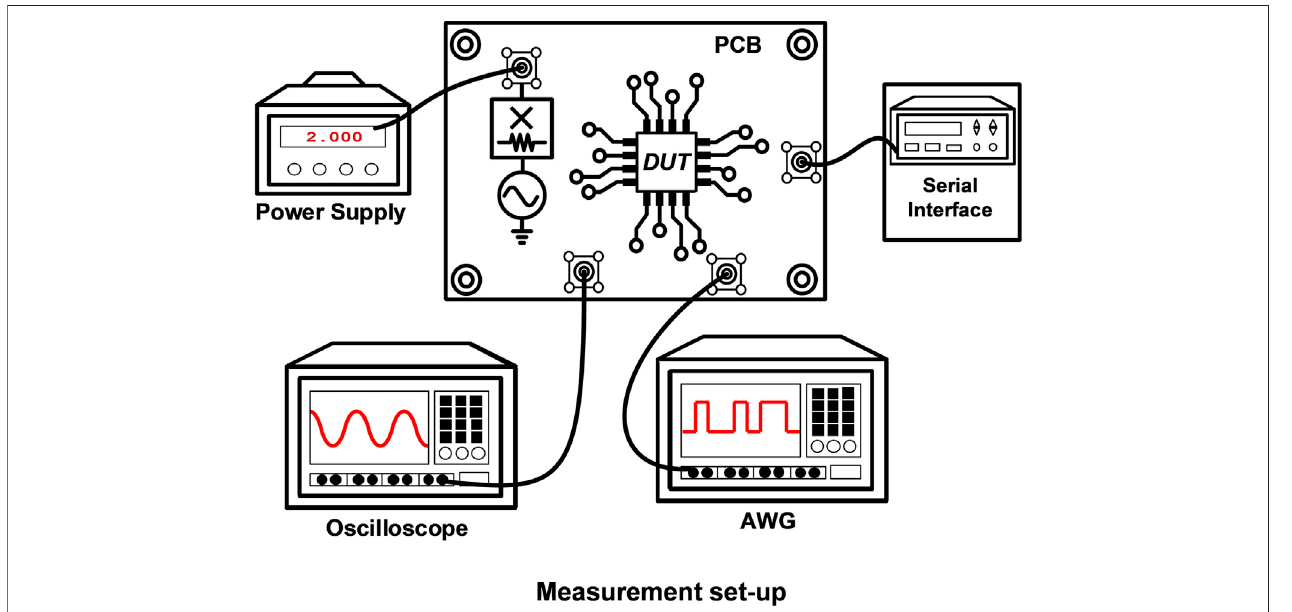
FIGURE 11 | Measurement